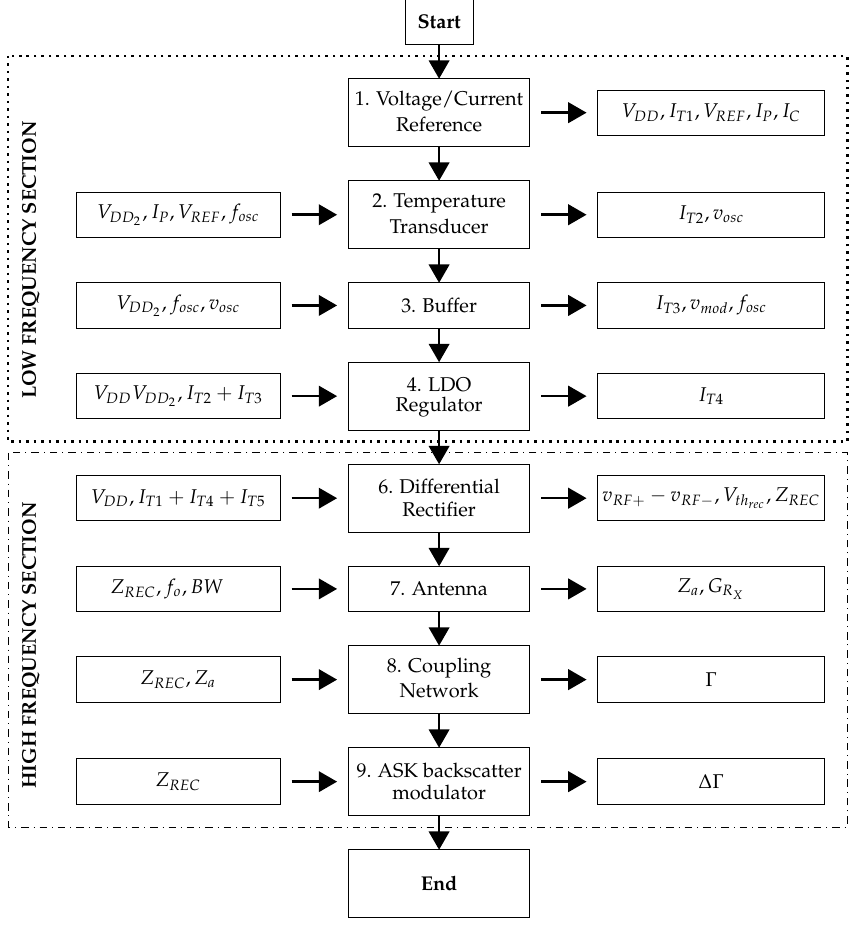
Figure 11. Design flow chart of the proposed